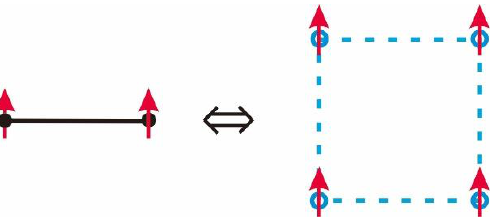
2 lattice gauge model.